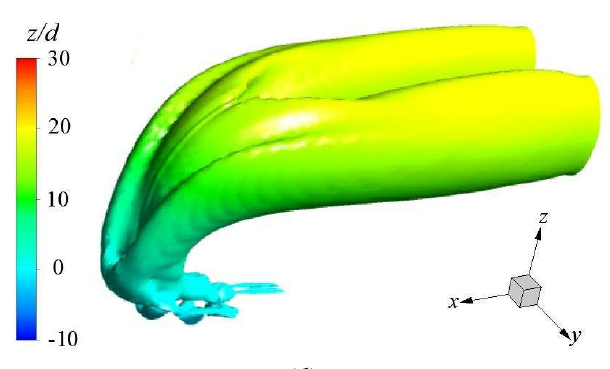
Figure 8. Comparison of the coherent structures of the buoyant jet in a counterflow (isosurfaces of vortex-identification criterion Q = 0.11 s −2 based on instantaneous velocity field colored by height z/d ): ( a – d ) simulated results for grids 1, 2, 3, and 4, respectively.